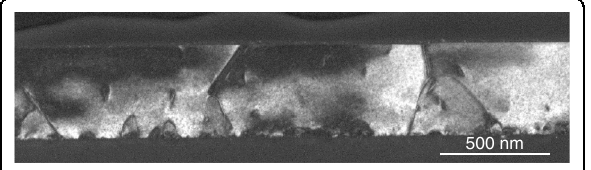
Fig. 3 Dark- fi eld cross-section TEM image of 500-nm-thick GaSb layer on 0.5-degree miscut Si (001) showing the burying of the APDs. Other defects such as dislocations are also visible. Reprinted with permission from ref. 93 . © John Wiley & Sons